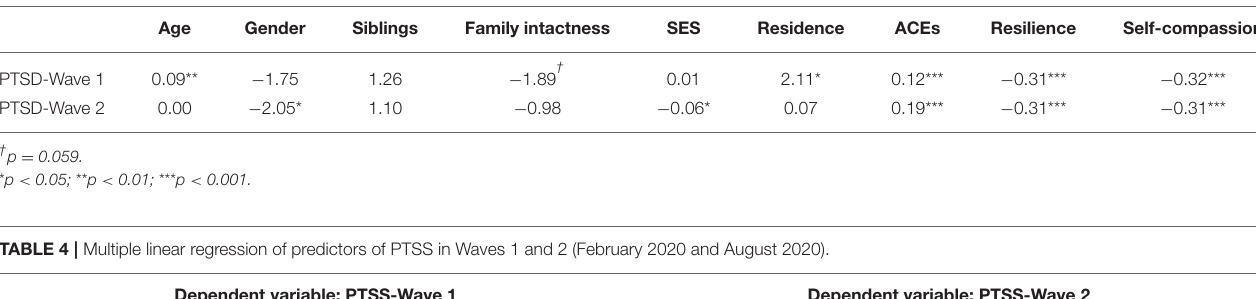
TABLE 3 | Correlations or t -test results of independent variables with PTSS in Waves 1 and 2 (February 2020 and August 2020).